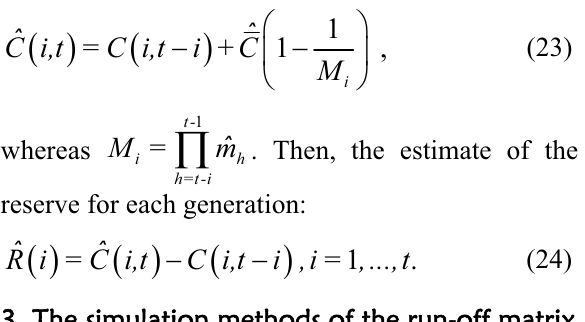
4. t Pseudo-random numbers, H